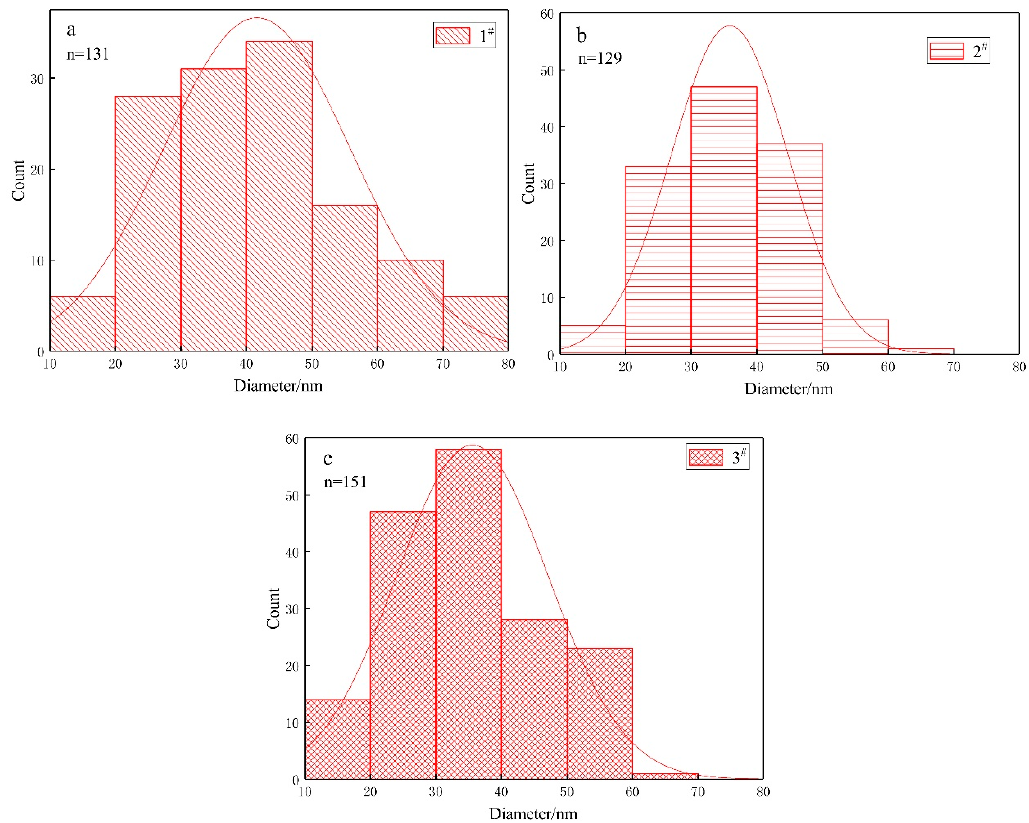
Figure 5. Histograms of the diameter of the nanoparticles synthesized by bacteria in media 1 # ( a ), 2 # ( b ), and 3 # ( c ). n represents the number of nanoparticles analyzed in each medium.